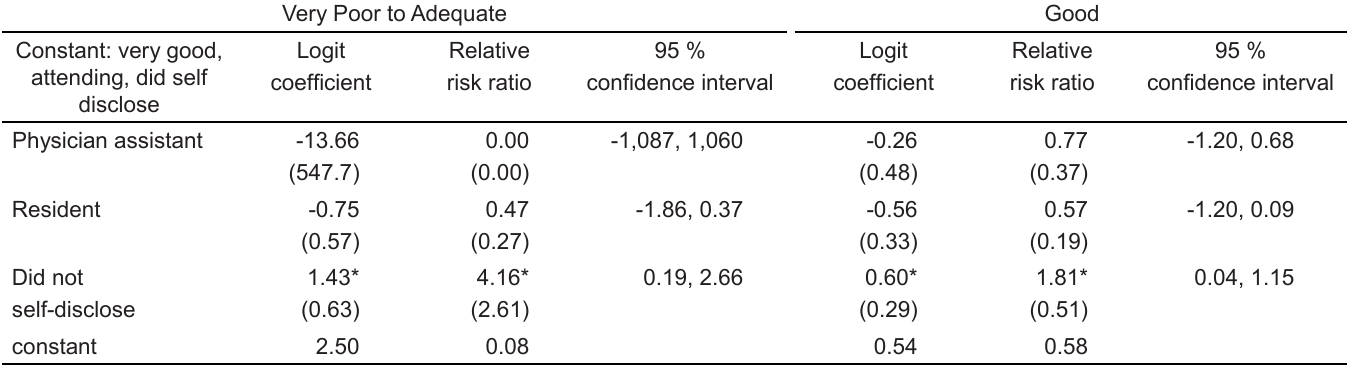
Table 2. Communication score related to self-disclosure by emergency department provider.